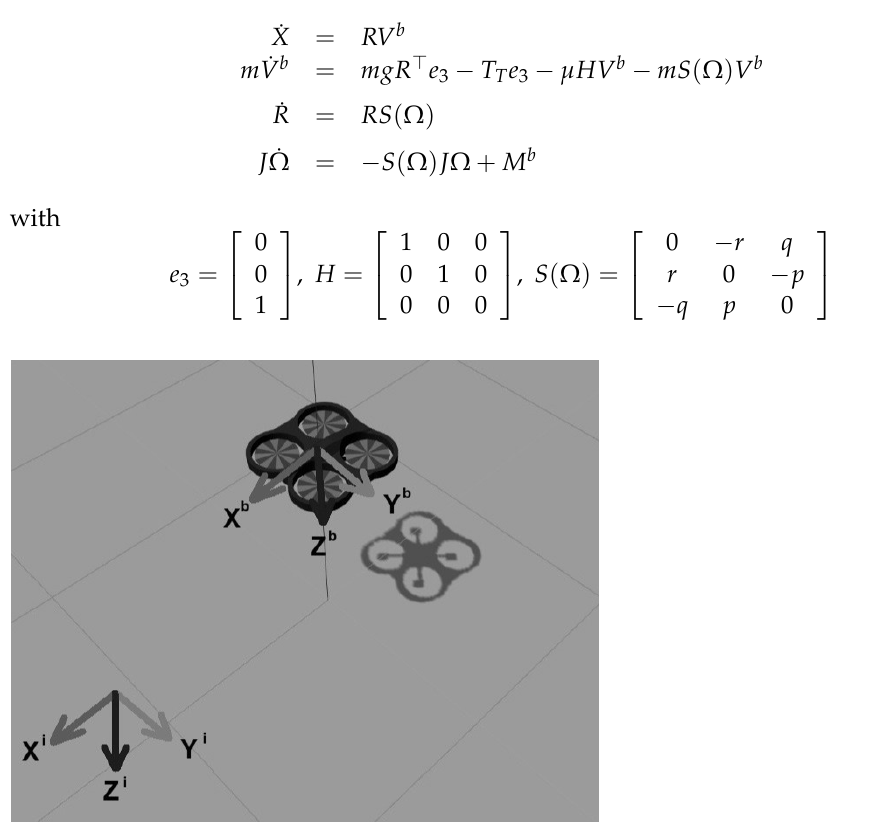
Figure 1. The following equations, expressed in mixed inertial and body coordinates,